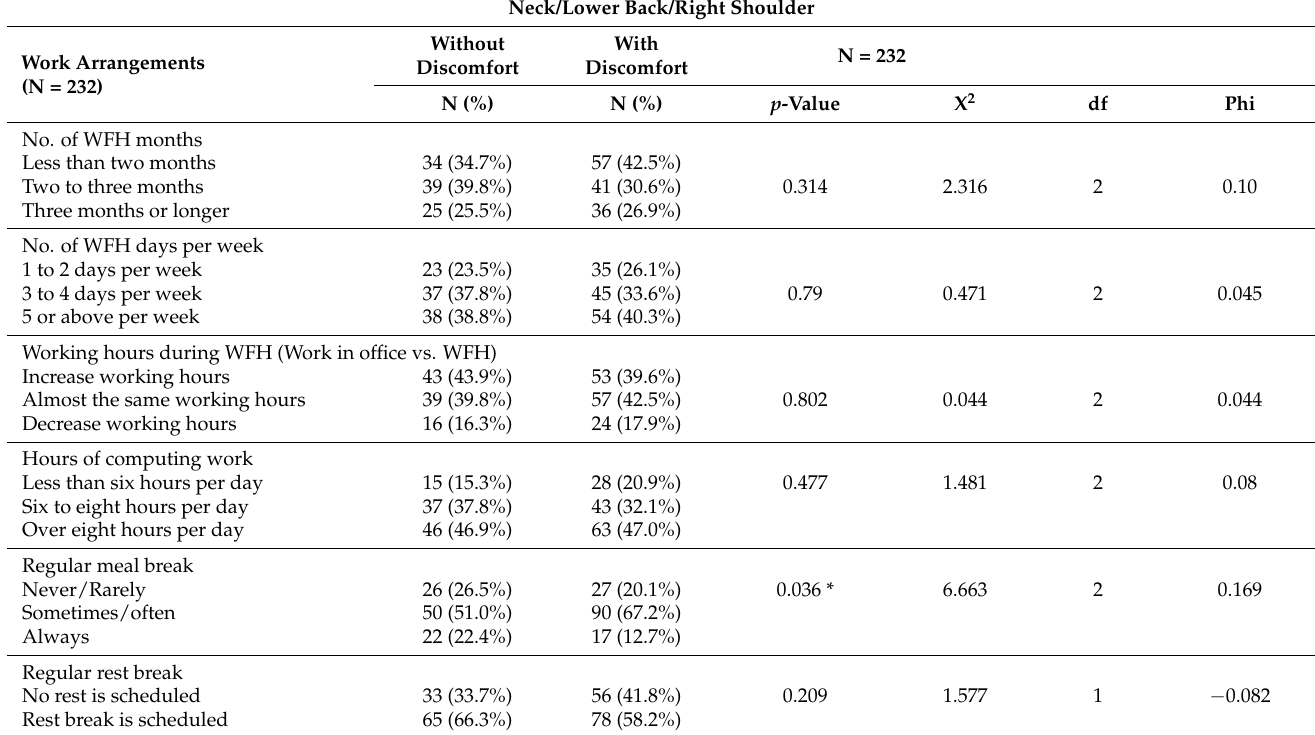
Table A5. The association between work arrangements and with/without neck or lower back or right shoulder.